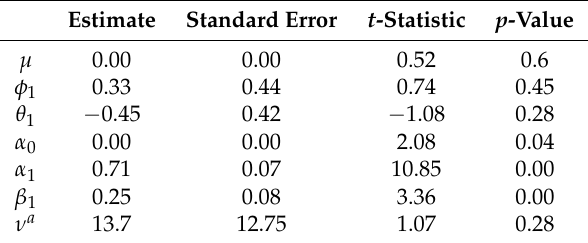
Table 3. Parameter estimates for fitting the sample residuals (cid:101) of (25).